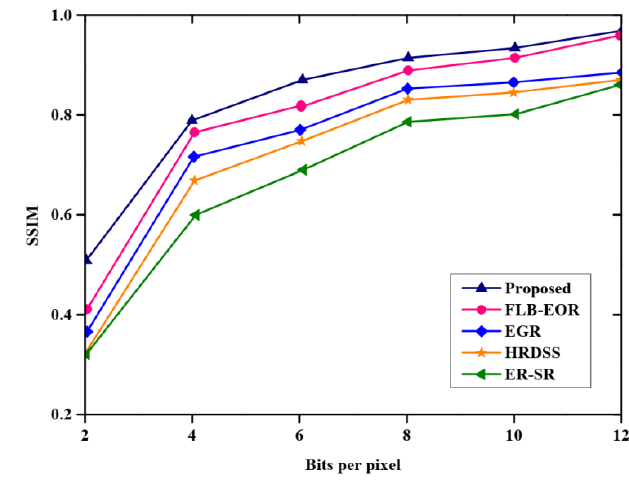
Figure 9. Comparative analysis of SSIM. Table 8. Comparative results based on packet delivery ratio.